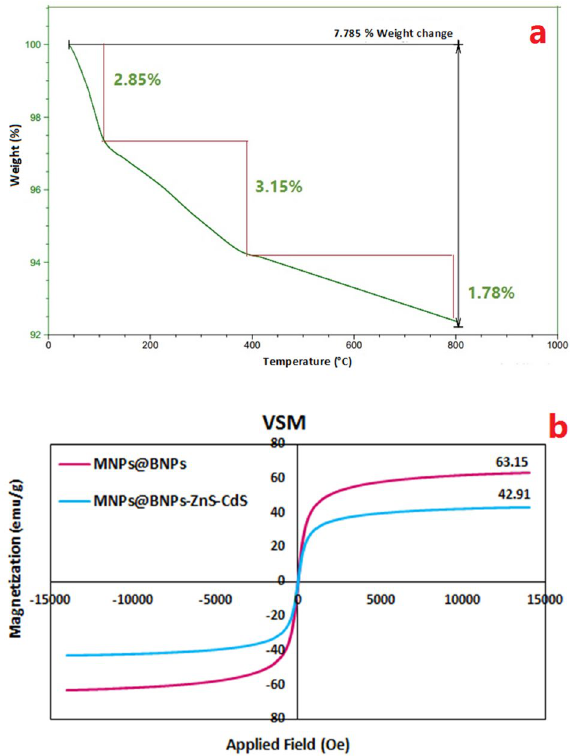
Figure 7. ( a ) TGA diagram for Fe 3 O 4 @BNPs@ZnS-CdS and, ( b ) VSM analysis for Fe 3 O 4 @BNPs@ZnS-CdS and